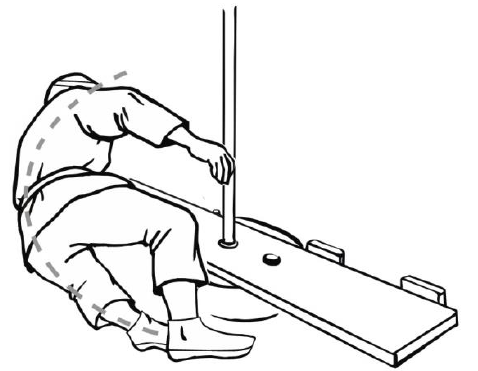
Figure 1. Fall performed backward with side aligning of the body.